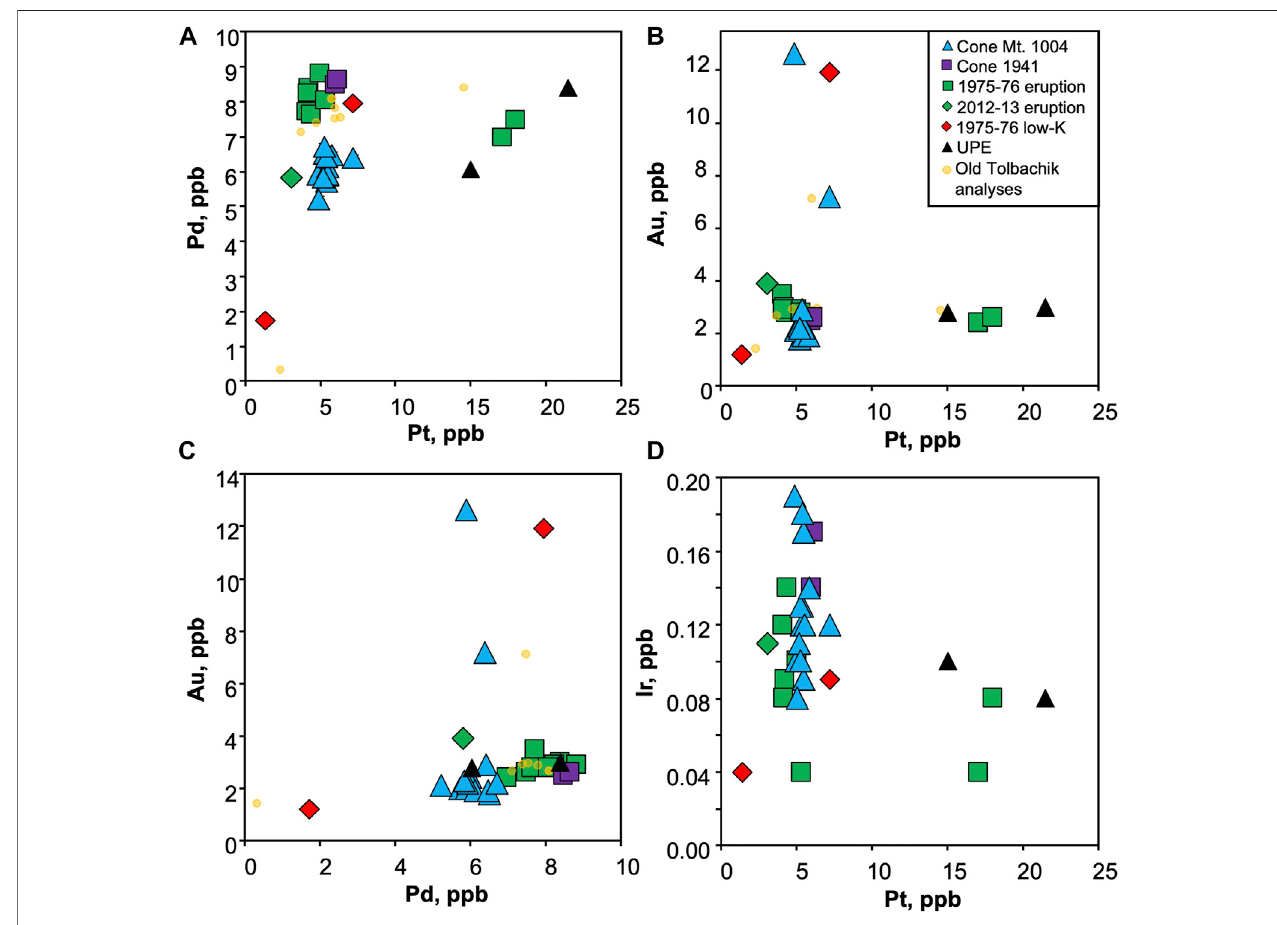
FIGURE 5 | Interelement PGE and Au variation for the Tolbachik volcano. Note Au and Pt anomalies, uncorrelated with concentrations of any other element analyzed.